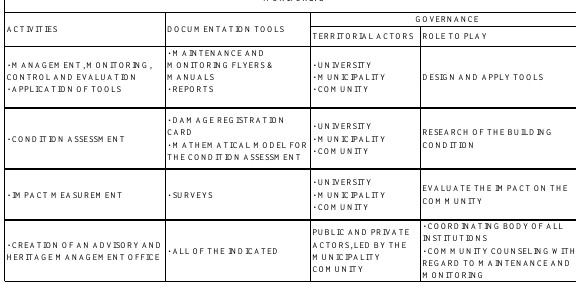
Table 2: Strategies for the management of built heritage linked to the control, maintenance and monitoring